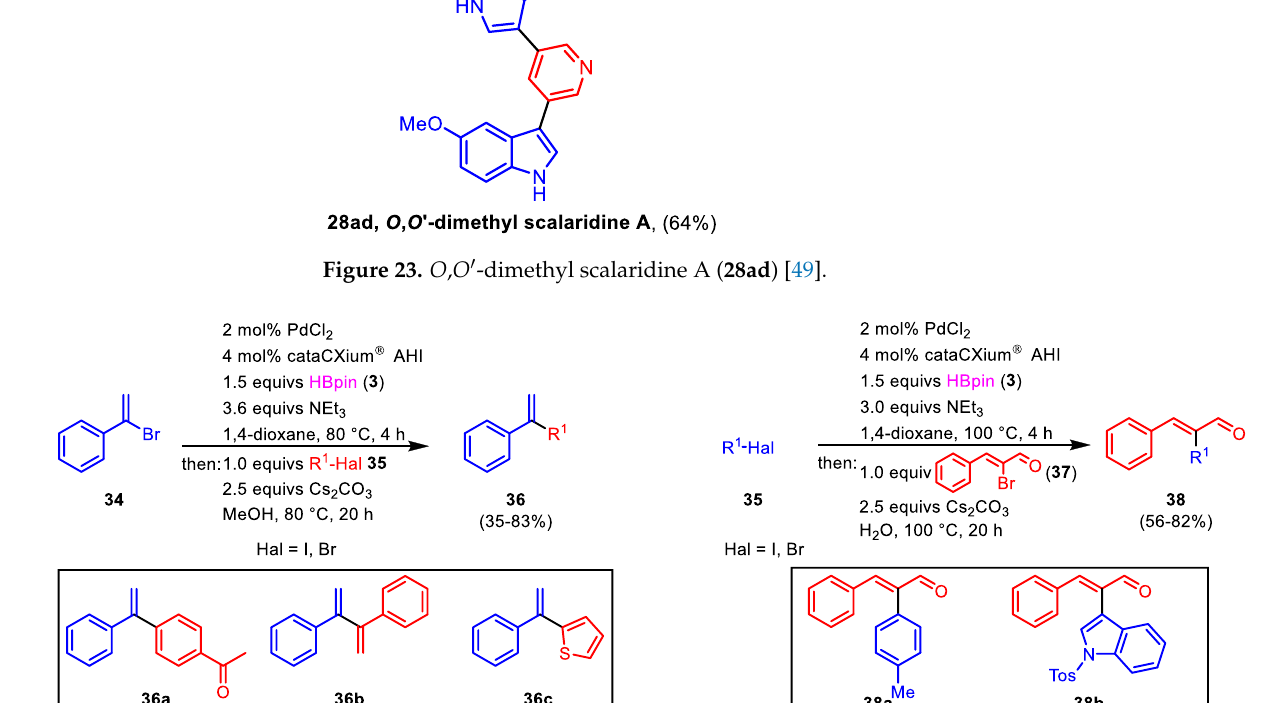
Figure 23. O , O‘ -dimethyl scalaridine A ( 28ad ) [49].